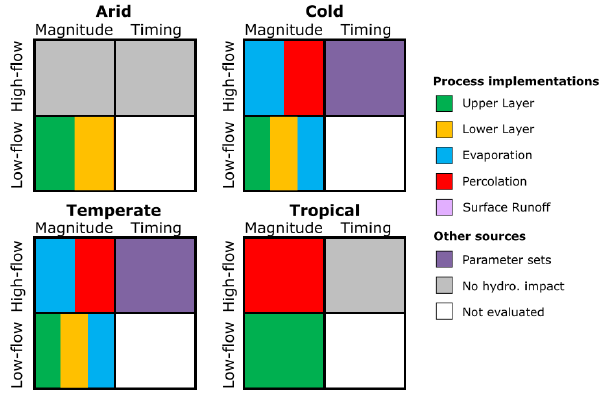
Figure 8. Summary of the results: indicated are the process for- mulations that significantly affect the distributions of the extreme runoff events in the different climate zones. The process implemen- tations refer to the formulation of hydrological processes in differ- ent model structures. “No hydro. impact” indicates that the effect of the hydrological model was limited, which implies that neither al- terations in the model structure nor alterations in the parameter sets significantly affected the simulated extreme runoff